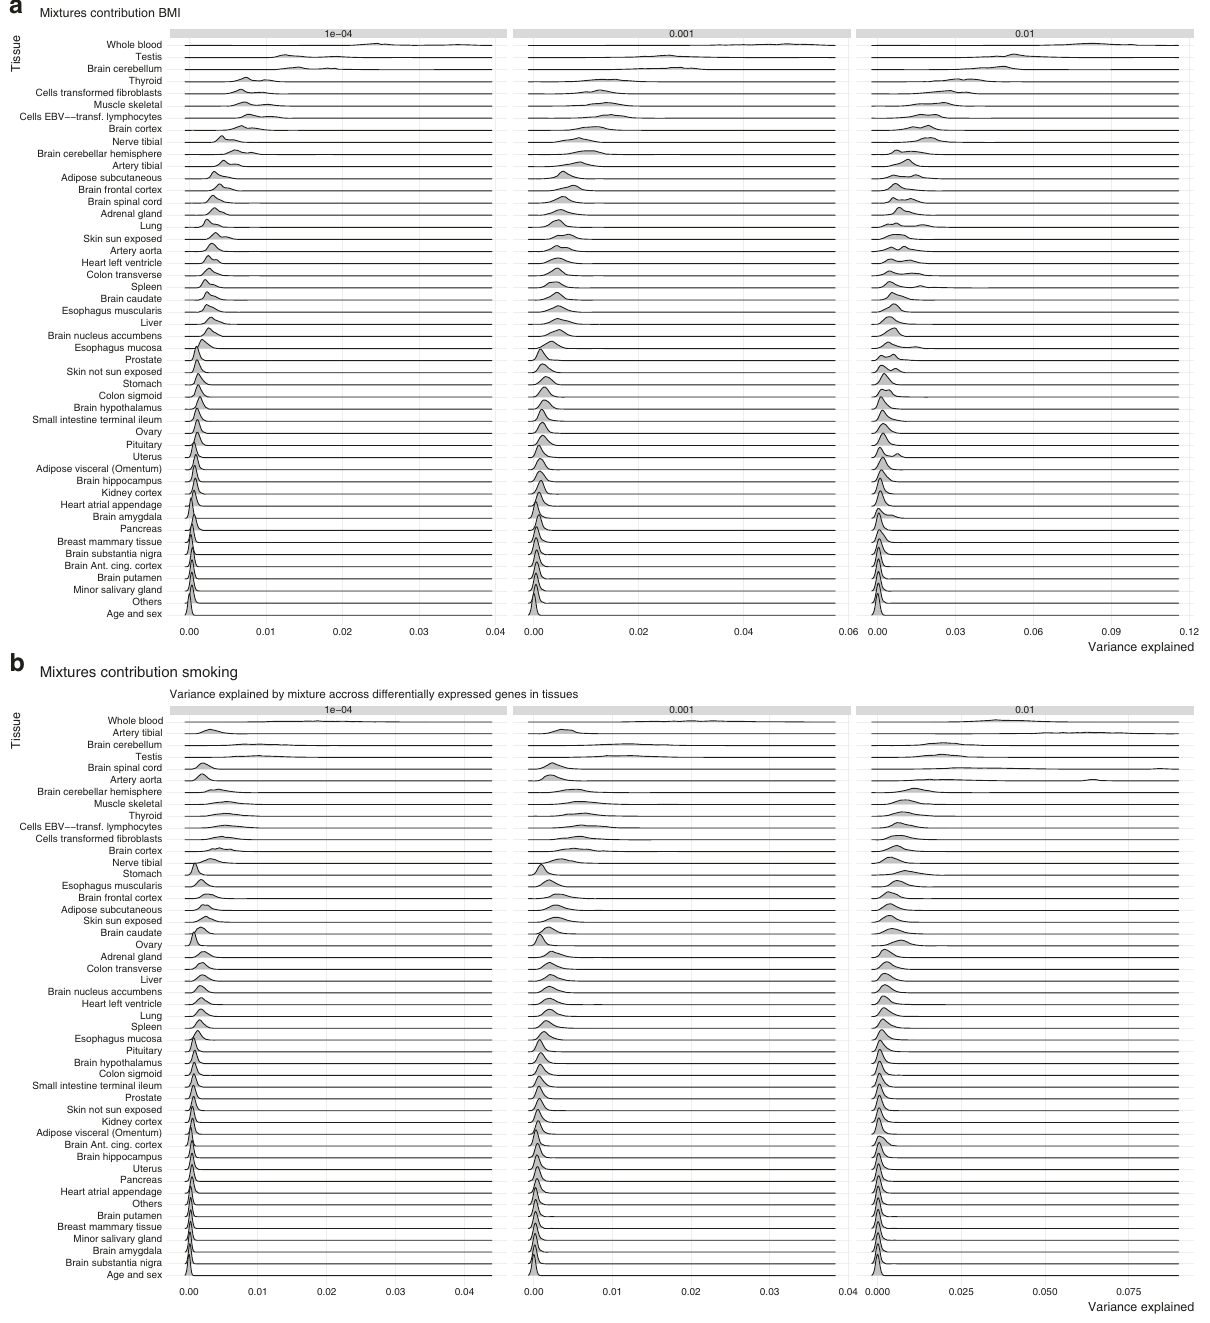
Fig. 4 Variance attributable to tissue-speci fi c gene expression. a , b Variance explained by probes that have tissue-speci fi c differentiated gene expression in Genotype-Tissue Expression (GTEx) project. Variance explained is decomposed by the mixture to which the posterior effects belong. For both traits, the biggest contribution comes from probes not mapped into genes differentially expressed in GTEx (not shown). From the probes that mapped into differentially expressed genes, in smoking, the biggest mixture (1% of the total variance explained by probes) captures probes mapping to genes differentially expressed in tibial and aorta arteries, along with the spinal cord, indicating these contribute more than what is observed by the rest of the probes among tissues and mixtures. For BMI, no such difference in effects distribution was observed among mixtures and among